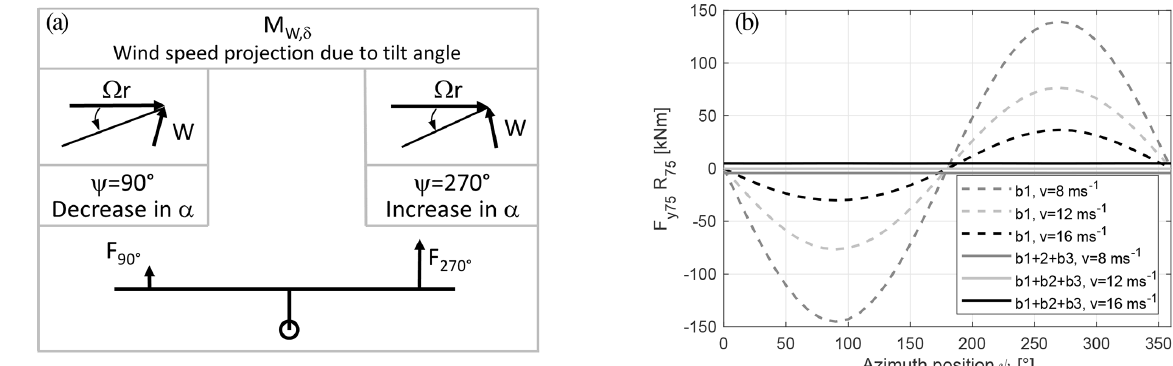
Figure 1. Aerodynamic yaw moment for the tilt angle of a downwind rotor sketched in (a) and the roughly estimated respective variation in yaw moment of the force at 75% rotor radius with 5 ◦ tilt in (b)